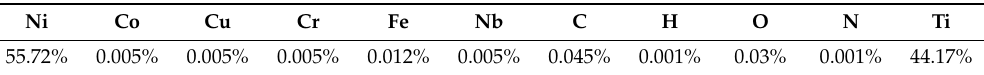
Table 1. Chemical compositions of NiTi alloys.